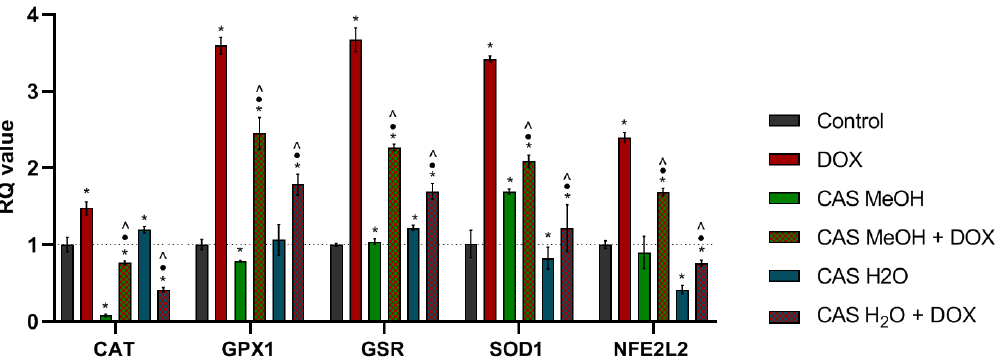
Figure 7. Relative mRNA expression levels of genes related to oxidative stress. BACT and RNA18SN5 were used as reference genes. Results were calculated as RQ values and are presented as means ± SDs. To compare more than two groups, one-way analysis of variance (ANOVA) and post hoc multiple comparisons based on Tukey’s HSD test were used. * p < 0.05 vs. control; • p <